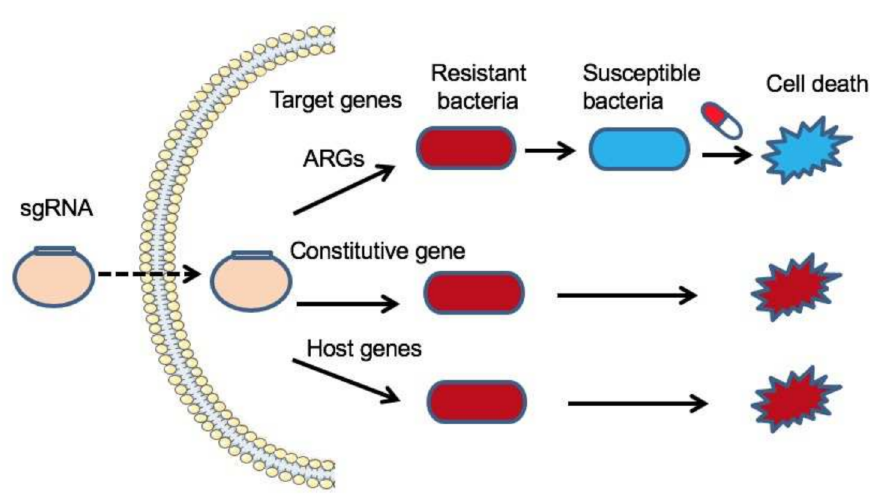
Figure 3. CRISPR-Cas system-based genome editing to combat bacterial infection. When the target genes are ARGs, the CRISPR-Cas system can restore the sensitivity of bacteria to antibiotics, and then the drugs will kill the susceptible bacteria. When the target genes are constitutive genes of the specific resistant bacteria, then the resistant bacteria will be killed. When the target genes are host chromosomal DNA that is cytotoxic to the resistant bacteria, the target cell will die because of the excision of the